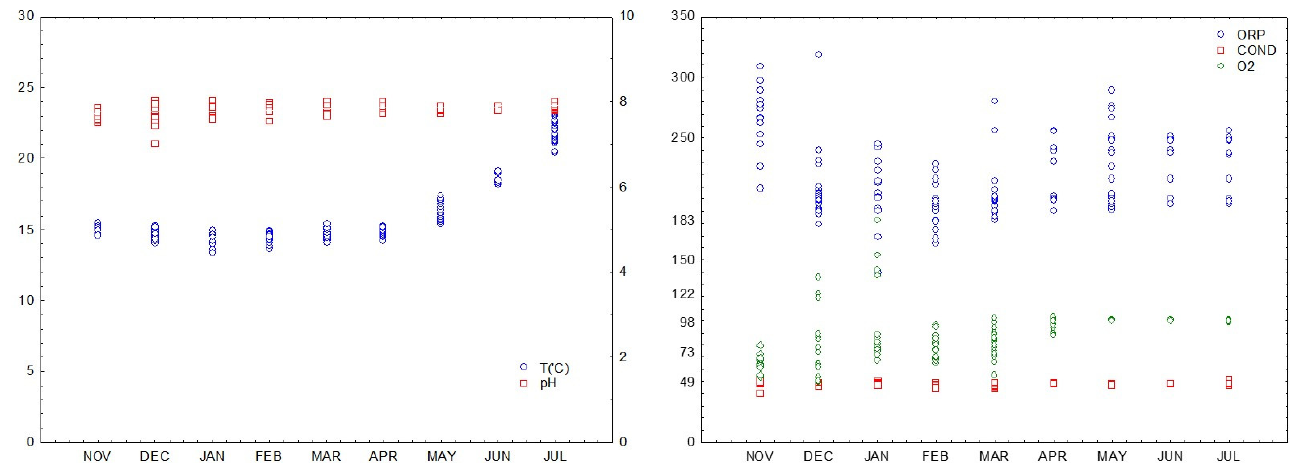
Figure 1. Temperature (T), pH, oxidation-reduction potential (ORP), conductivity (COND) and oxygen concentration (O2) during the investigated seasons measured in ex situ conditions.